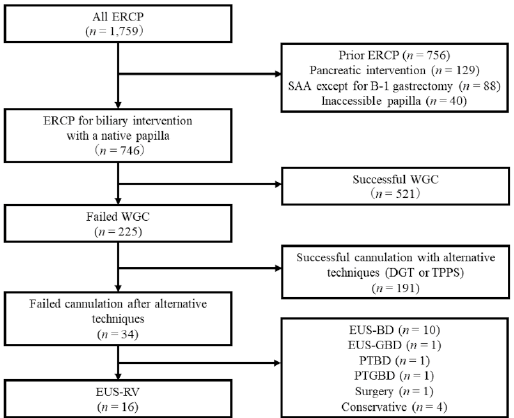
Figure 6. Flowchart of the study patients. ERCP: endoscopic retrograde cholagiopancreatography; SAA: surgically altered anatomy; WGC: wire-guided cannulation; DGT: double guidewire technique; TPPS: transpancreatic precut sphincterotomy; EUS-RV: endoscopic ultrasound-guided rendezvous; EUS-BD: endoscopic ultrasound-guided biliary drainage; PTBD: percutaneous transhepatic biliary drainage; EUS-GBD: endoscopic ultrasound-guided gallbladder drainage; PTGBD: percutaneous transhepatic gallbladder drainage